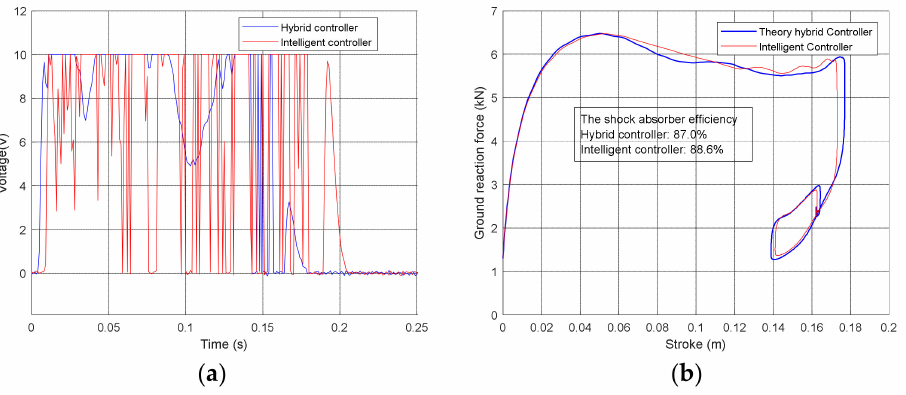
Figure 14. ( a ) Voltage applied to MR core, ( b ) efficiency curve. The drop test results of the landing gear using the hybrid controller with exact information and intelligent controller in the case of m 1 = 220 kg, v = 2.32 m/s (different from training and testing